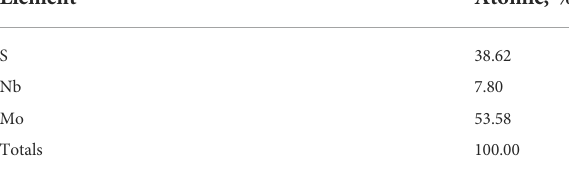
TABLE 1 The atomic ratios of S, Mo and Nb for Nb-MoS 2 NSs. Element Atomic,